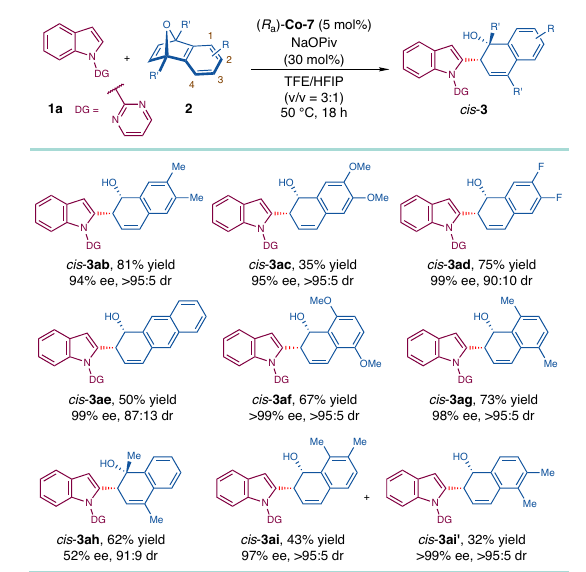
Fig. 3 | Substrate scope: 7-Oxabenzonorbornadienes. Reaction conditions: 1a (0.10mmol), 2 (0.15mmol), ( R a )- Co-7 (5mol%), NaOPiv (30mol%) in TFE/HFIP (0.4mL, v/v=3:1) at 50°C for